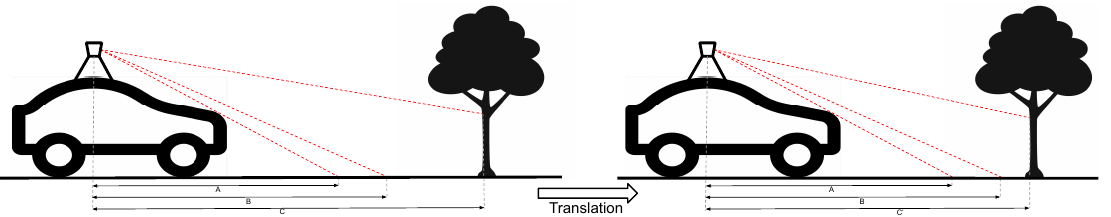
Figure 5. Distance obtained from ground points and distance from object points after vehicle